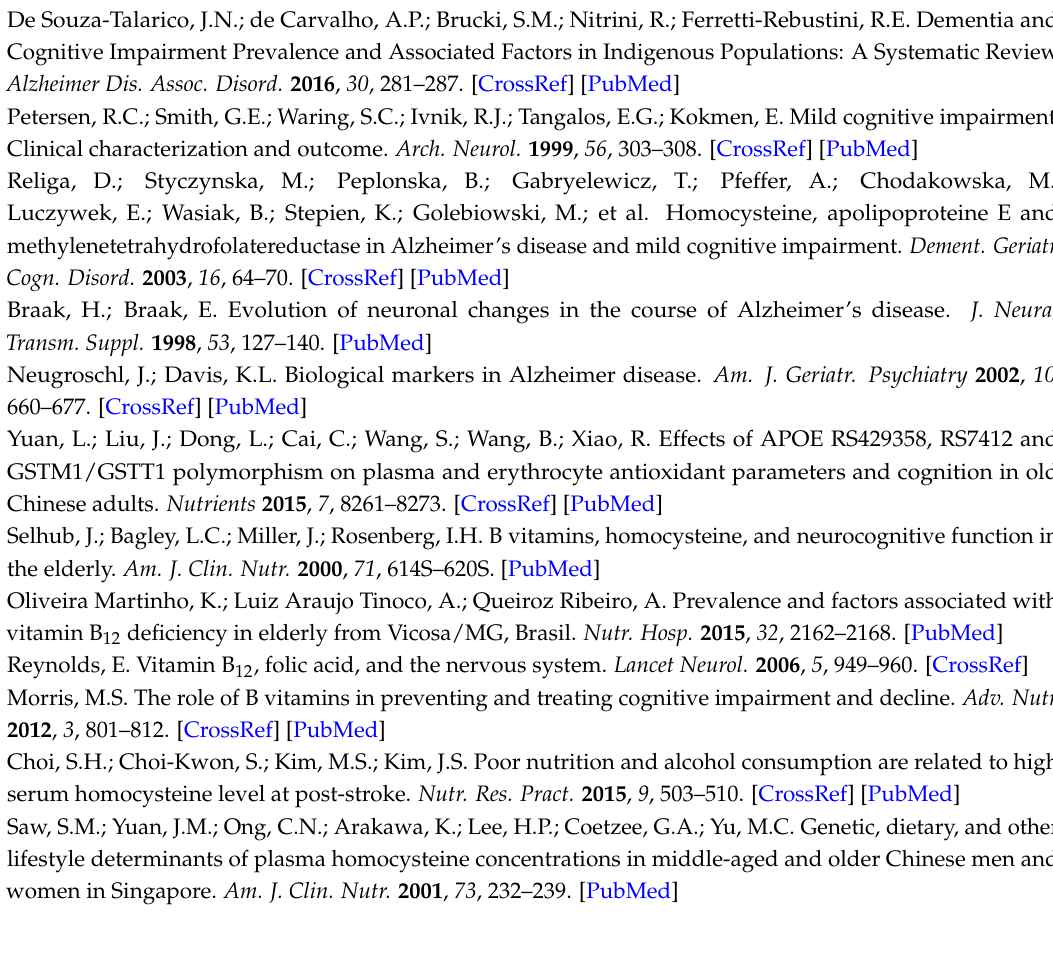
Table S1: MoCA scores by serum folate level and MTHFR C677T genotypes, Table S2: MoCA scores by serum vitamin B 12 level and MTHFR C677T genotypes, Table S3: MoCA scores by serum Hcy level and MTHFR C677T genotypes, Table S4: MoCA scores by serum folate level and MTHFR A1298C genotypes, Table S5: MoCA scores by serum vitamin B 12 level and MTHFR A1298C genotypes, Table S6: MoCA scores by serum Hcy level and MTHFR A1298C genotypes, Table S7: MoCA scores by serum folate level and SLC19A1 G80A genotypes, Table S8: MoCA scores by serum vitamin B 12 level and SLC19A1 G80A genotypes, Table S9: MoCA scores by serum Hcy level and SLC19A1 G80A